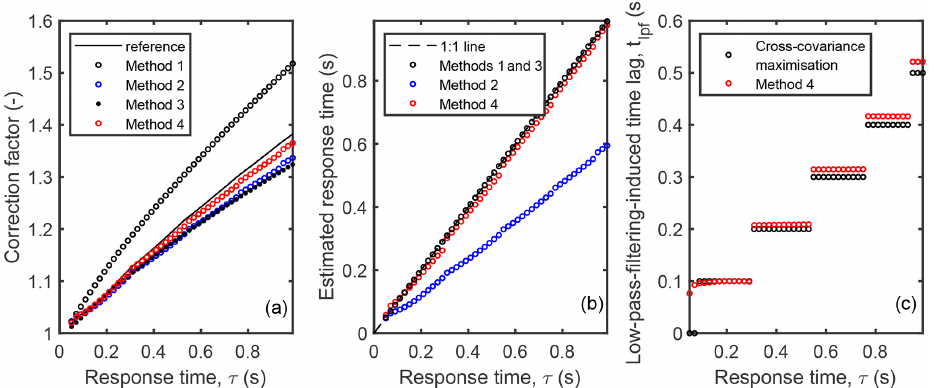
Figure 5. Comparison of estimated correction factors and response times to the values used to attenuate the T time series. The reference values for the correction factors were calculated as the ratio between w (cid:48) T (cid:48) and w (cid:48) ˆ T (cid:48) , where ˆ T is the temperature time series attenuated according to Sect. 3.2.2. Note that w (cid:48) ˆ T (cid:48) was calculated using cross-covariance maximisation. The time lags obtained from cross-covariance maximisation and from fitting HH p to H e , cs are shown in panel (c) . The same data were used as in Figs. 3 and